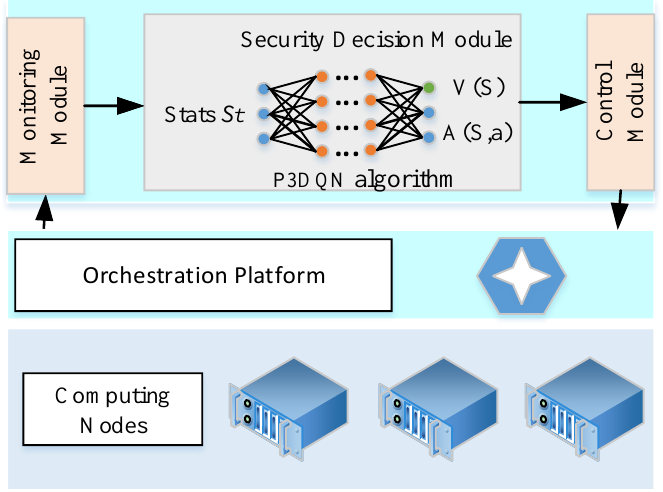
Figure 2. The workflow of the proposed OADSF.